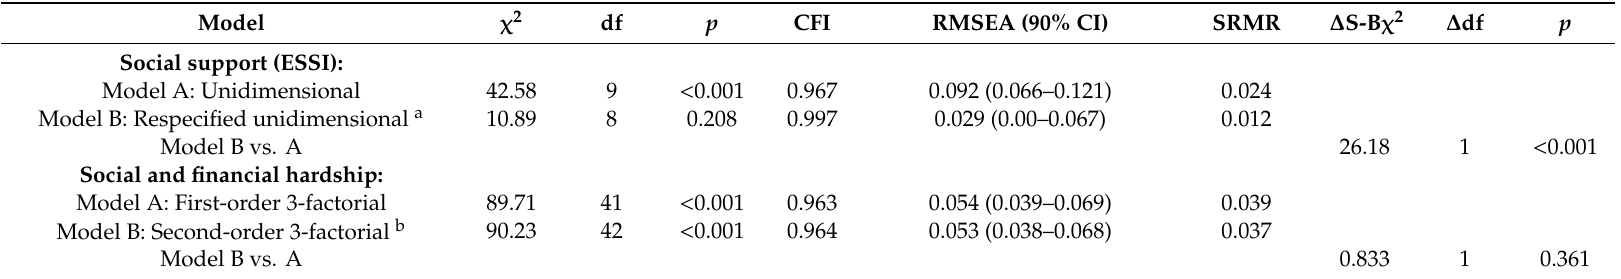
Table 3. Fit indices of measurement